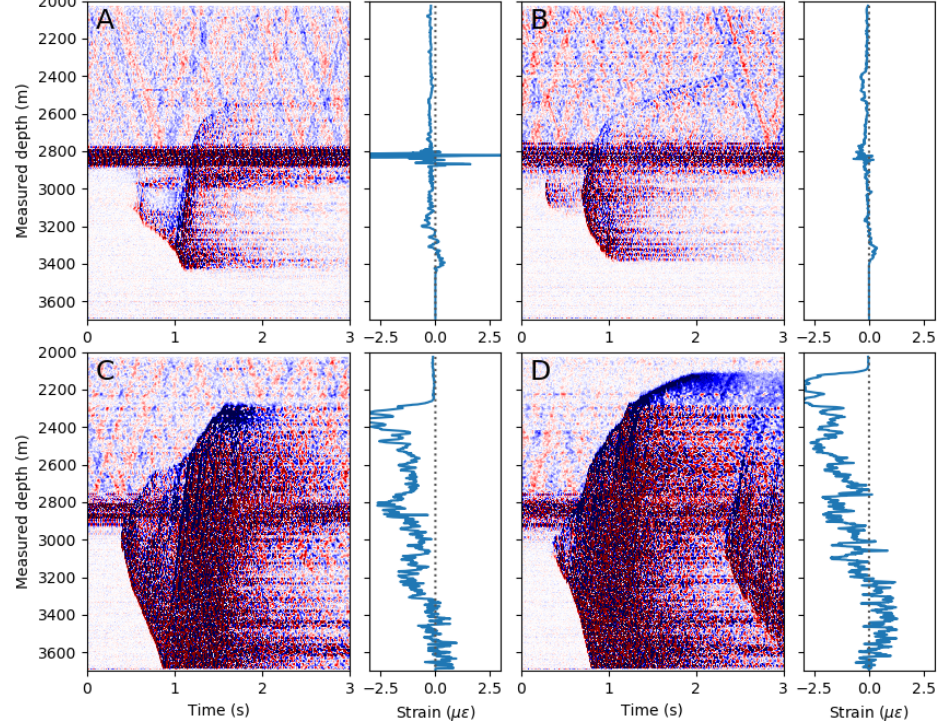
Figure 6. Four raw DAS data examples of sucker rod events with the integrated strain rate ( ε DAS ) over a period of 3s. The timing of the events relative to the start of cold-water injection is as follows: A – + 65min; B – + 110min; C – + 147min; D – 210min.